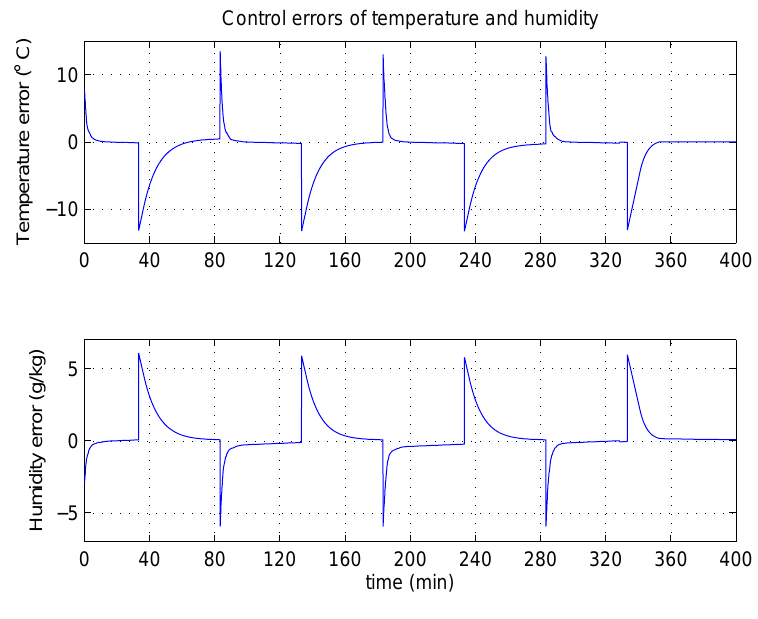
Figure 7. Variation of Neuro-PID control errors during the tuning process.